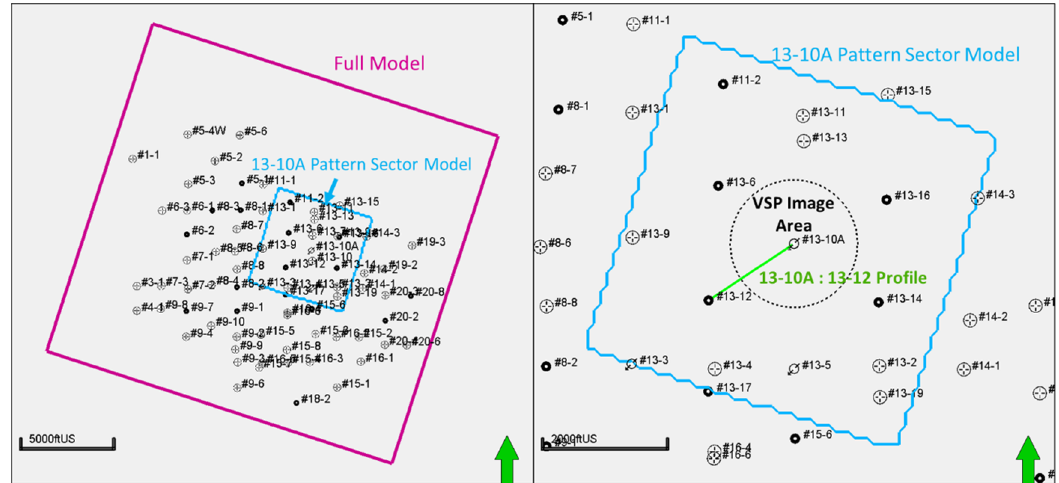
Figure 8. ( left ) Full simulation model (magenta) and 13-10A pattern sector model (blue) boundaries. ( right ) 13-10A pattern sector model boundary (blue), well 13-10A: 13-12 study profile (green), VSP image area (black stippled).